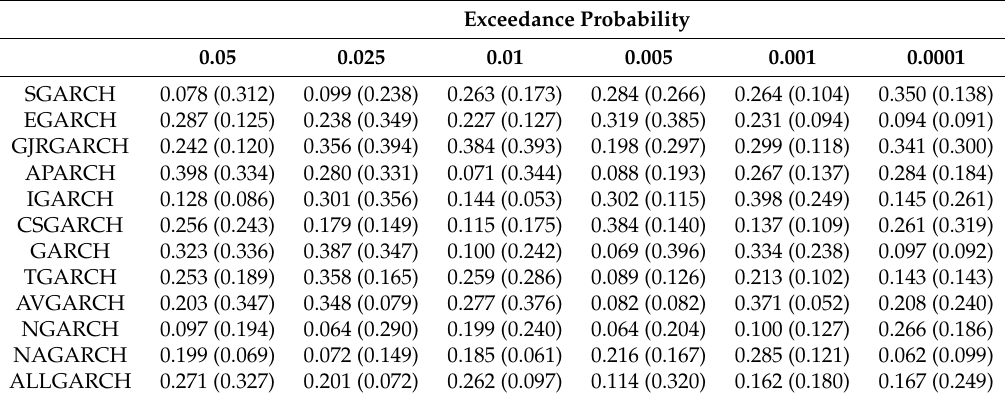
Table 2. p -values of the unconditional (conditional) coverage value at risk exceedance test for the log returns of the exchange rates of Bitcoin from 22 June 2014–17 May 2017.